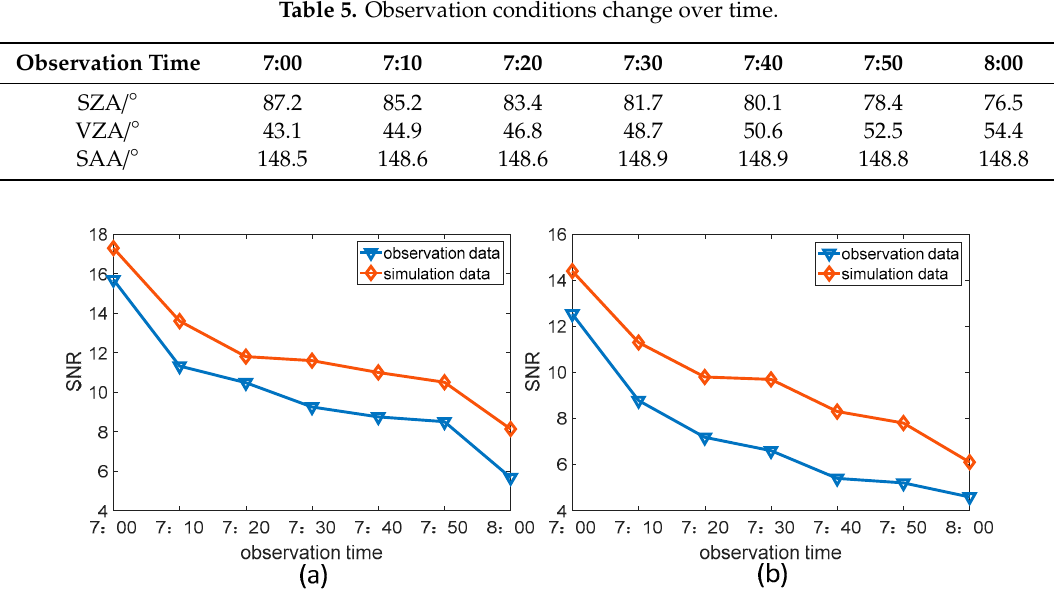
Figure 13. Hip2840 detection results. ( a ) No filter, ( b ) 1.3 um filter, ( c ) 1.5 um filter.